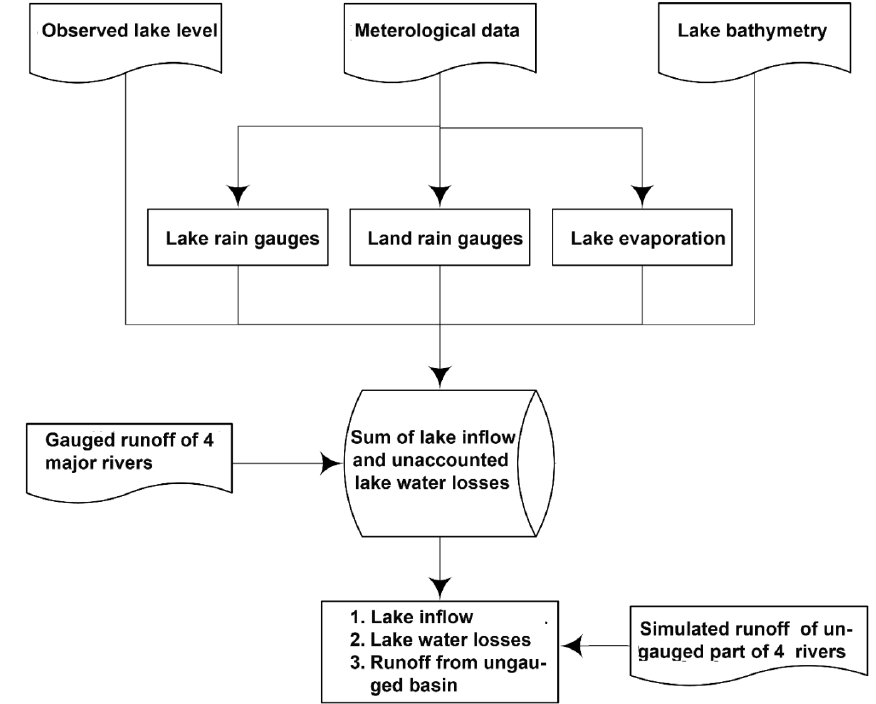
Figure 2. Flow diagram representing the computational methods.